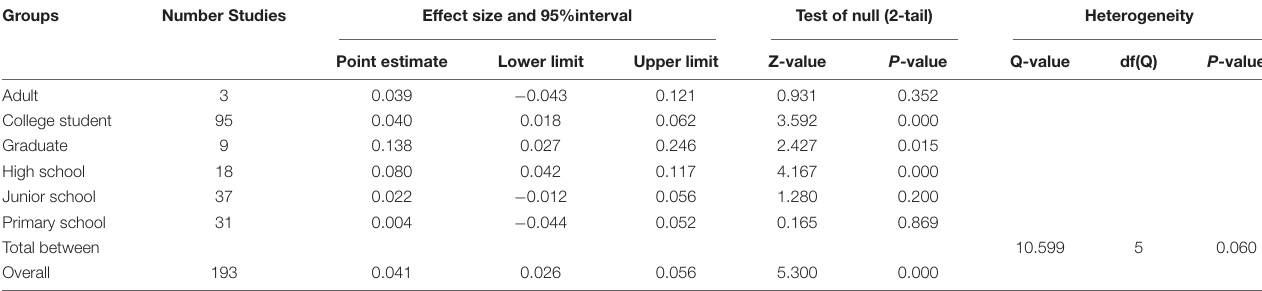
TABLE 1 | Summary of moderated effects of identity for the association between gender and procrastination.